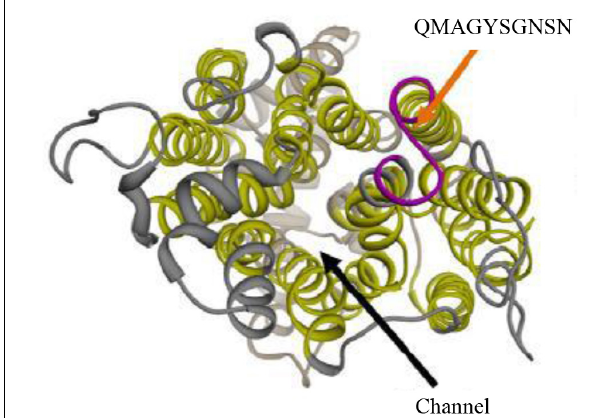
FIGURE 1 | 3D schematic representation of Hgt1p. The polyclonal antibody anti-Hgt1p, used in this project, was commercially generated by ProteoGenix, Schiltigheim, France. It recognizes an epitope exposed in an extracellular portion of Candida albicans cell membrane (upper